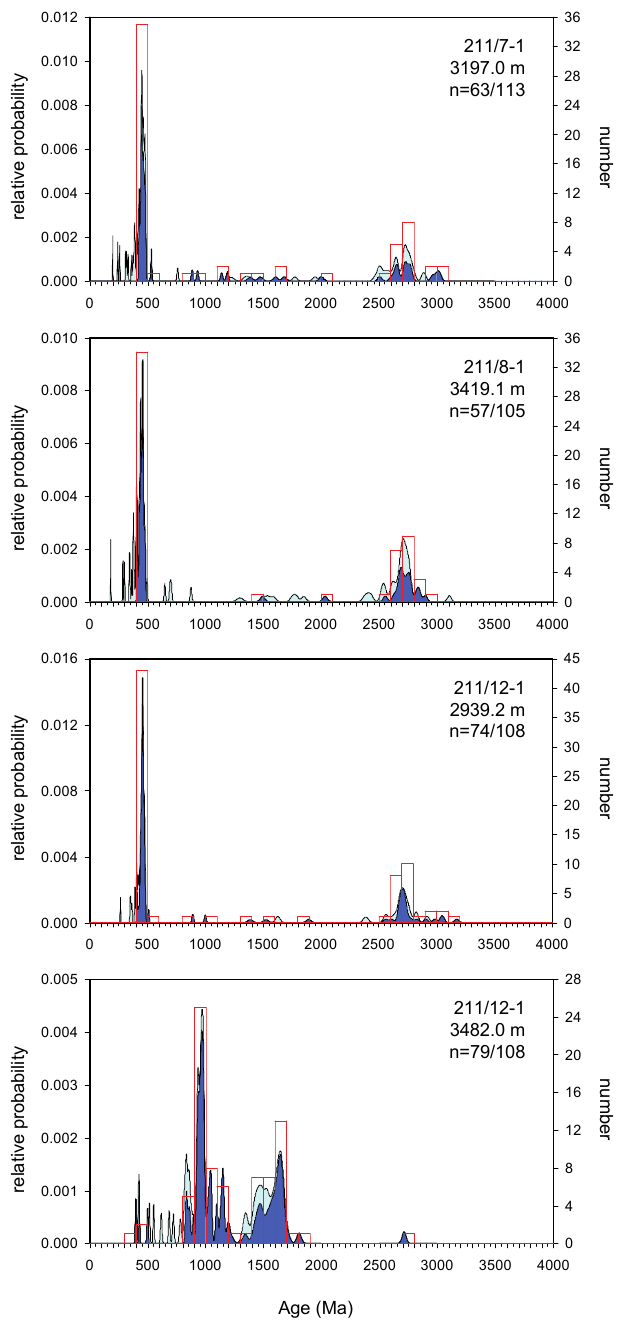
Figure 12. Probability-density plots of detrital zircon ages in three Magnus Sandstone Member samples (211/7-1, 3197.0 m; 211/8-1, 3418.1 m; 211/12-1, 2938.2 m) and one Ptarmigan Sandstone Member sample (211/12-1, 3482.0 m), confirming the rutile geochemical evidence for a difference in provenance. ‘n’ is number of zircons with <10% discordance in the total zircon